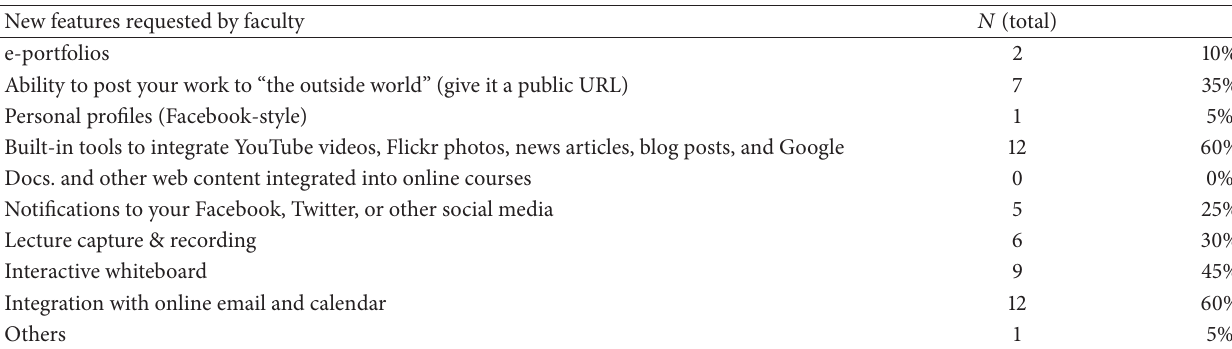
Table 6: New features requested by